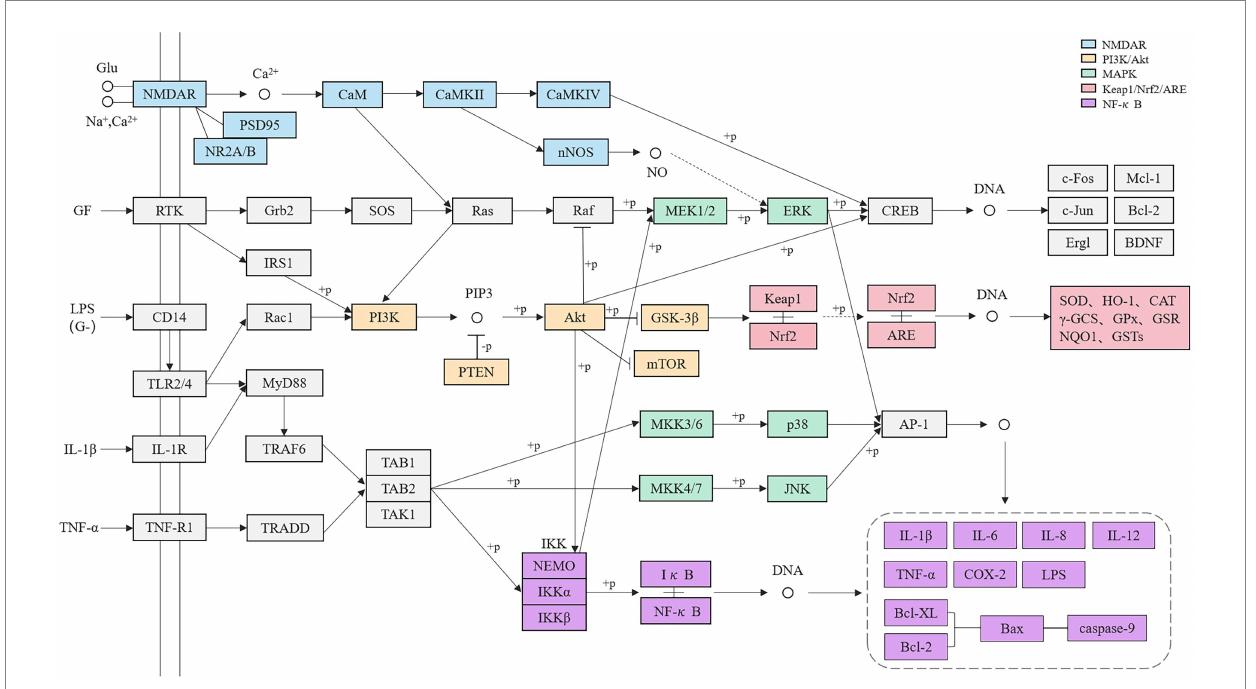
FIGURE 2 Related pathways network of pesticides poisoning affecting learning and memory